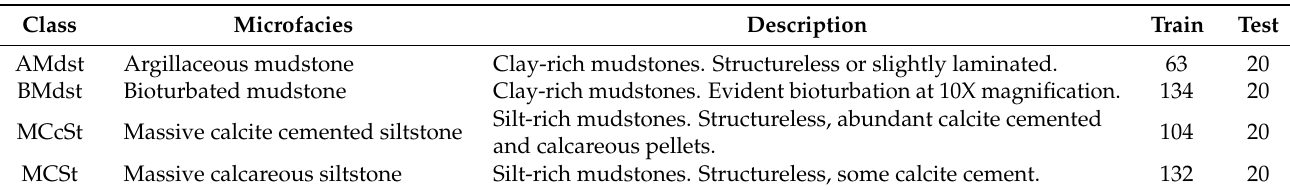
Table 1. Thin-section data details.